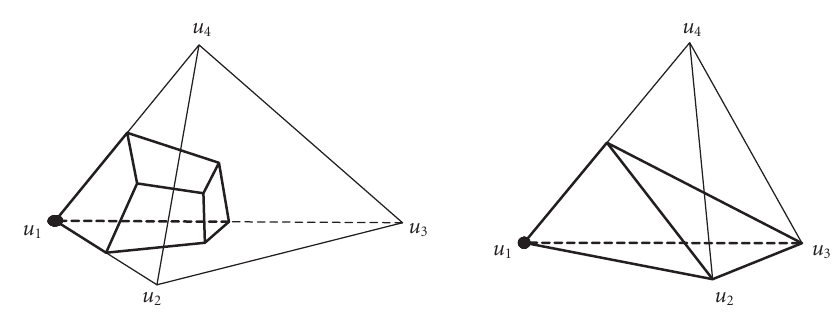
Figure 3.3. Two horoballs centered at u 1 with π ( g { 2,3,4 } ) equal to ( u 2 + u 3 + u 4 ) / 3 on the left and ( u 2 + u 3 ) / 2 on the